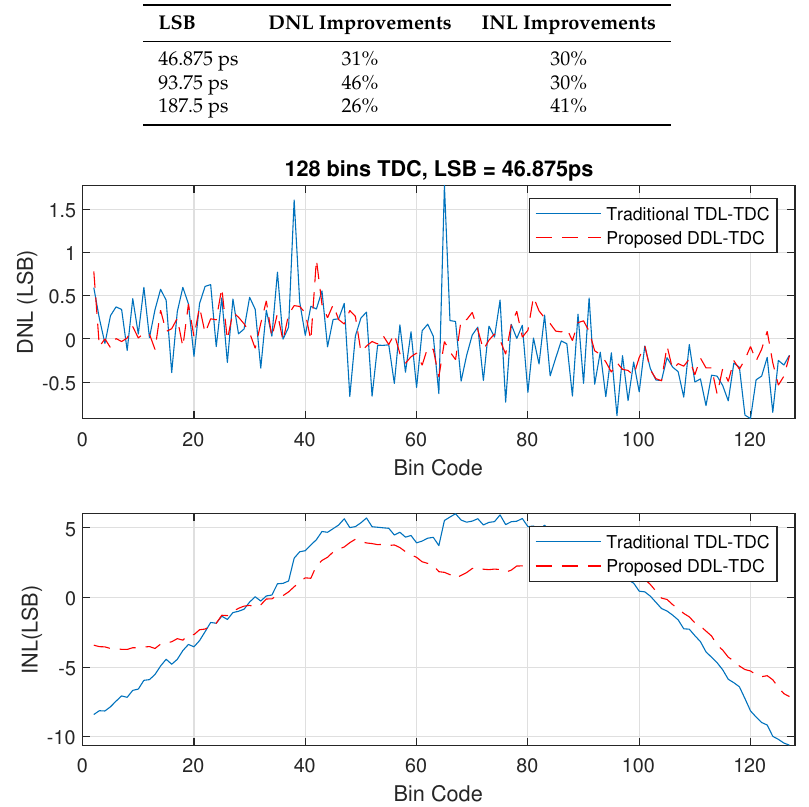
Figure 7. INL/DNL values obtained using the proposed DDL-TDC with 7-bit digital